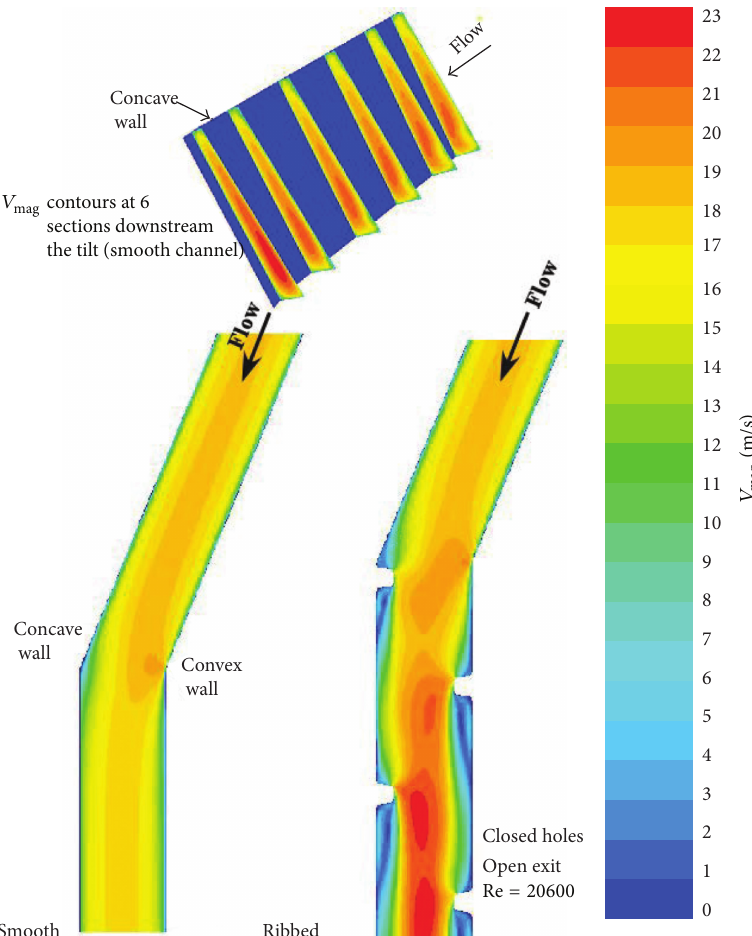
Figure 9: Velocity magnitude contours on the mid-plane around the channel tilt (bottom) and on six sections downstream the tilt (top) for the case of closed trailing-edge holes and open